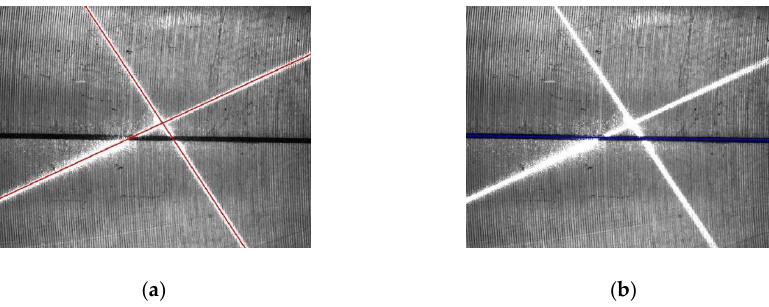
Figure 10. Extracted lines with a precise Hough transform. ( a ) Laser stripe lines. ( b ) Joint line.